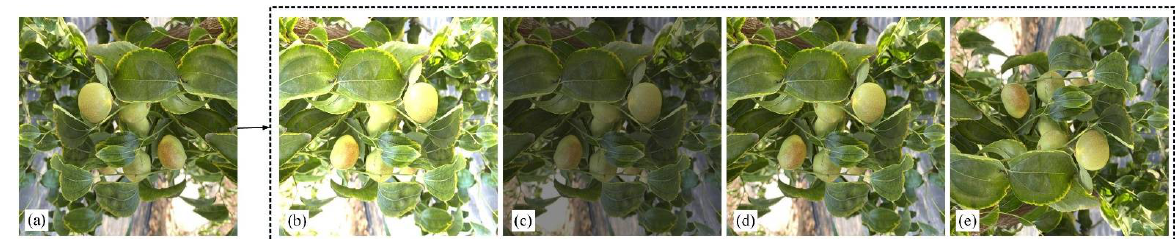
Figure 14. Typical failure samples. ( a ) Samples under backlight and occlusion scenes. ( b ) Samples under large field of view.